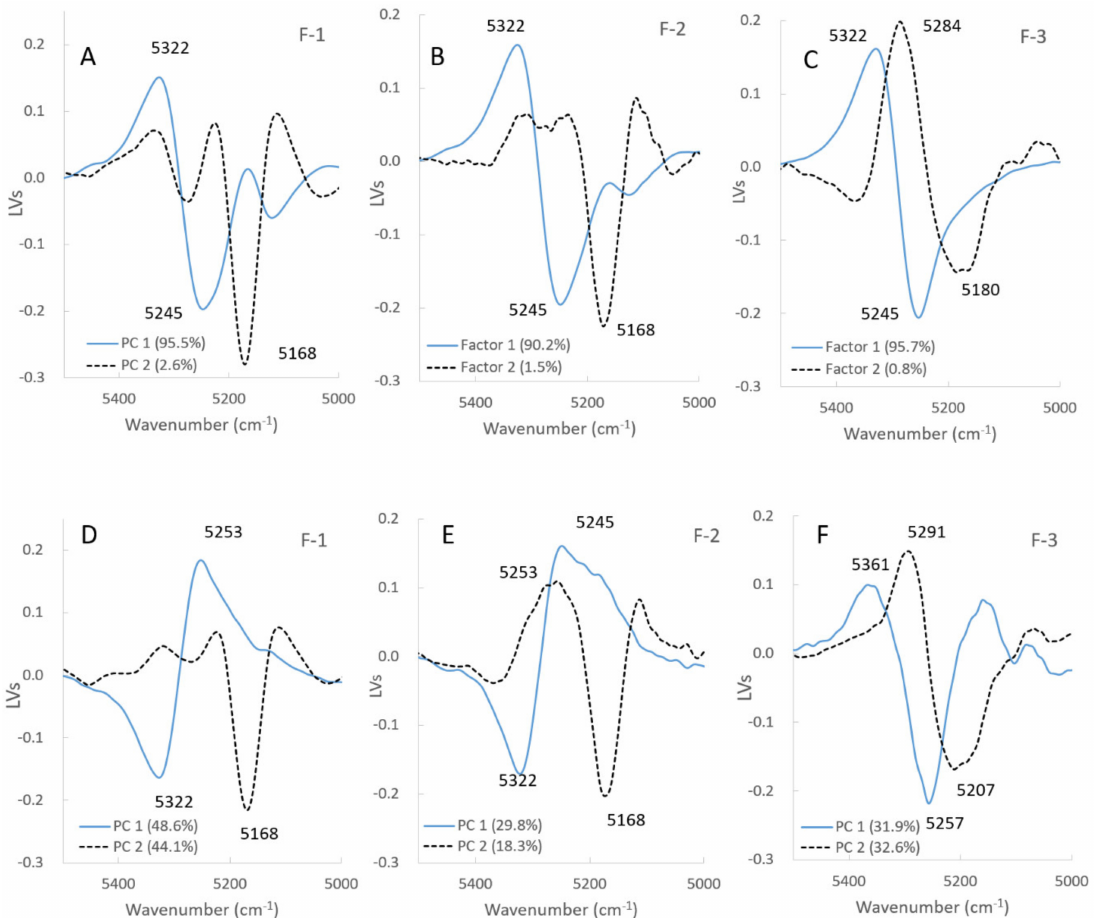
Figure 5. ( A – C ) Latent variables of the calibration models to predict the amount of water added and the agitation power consumption of all formulations. ( A – C ), the amount of water for lactose, mixture, and starch samples. The solid line is LV1, the dot line is LV2. ( D – F ) Latent variables of the calibration models to predict the amount of water added and the agitation power consumption of all formulations. ( D – F ), the agnation power consumption for lactose, mixture, and starch samples. The solid line is LV1, dot line is